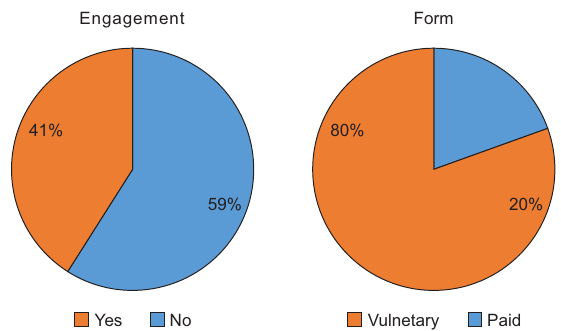
Fig. 8. The level of engagement of young people and the form of engagement.